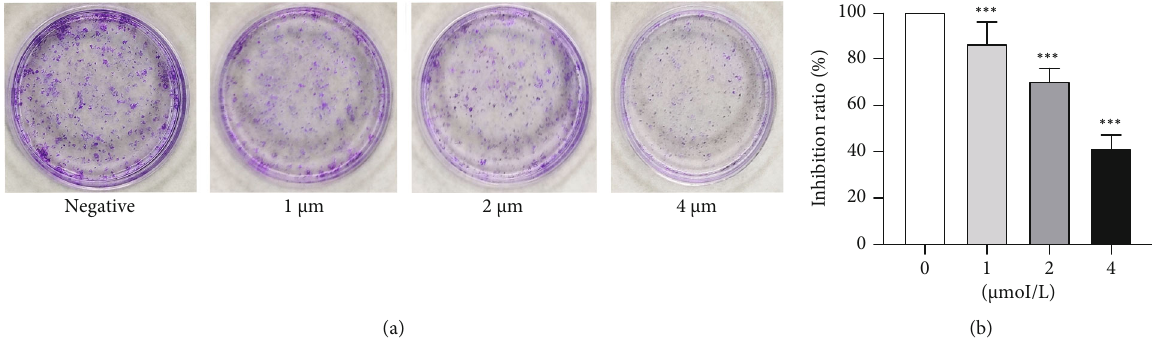
Figure 2: Anlotinib inhibited the proliferation of HSC-3 cells. HSC-3 cells were treated with di ff erent concentrations (0, 1, 2, and 4 μ M/L) of anlotinib for 10 days. (a) The e ff ect of anlotinib on proliferation of HSC-3 cells. (b) Inhibition ratio of anlotinib on proliferation of HSC-3 cells. The results are from three independent